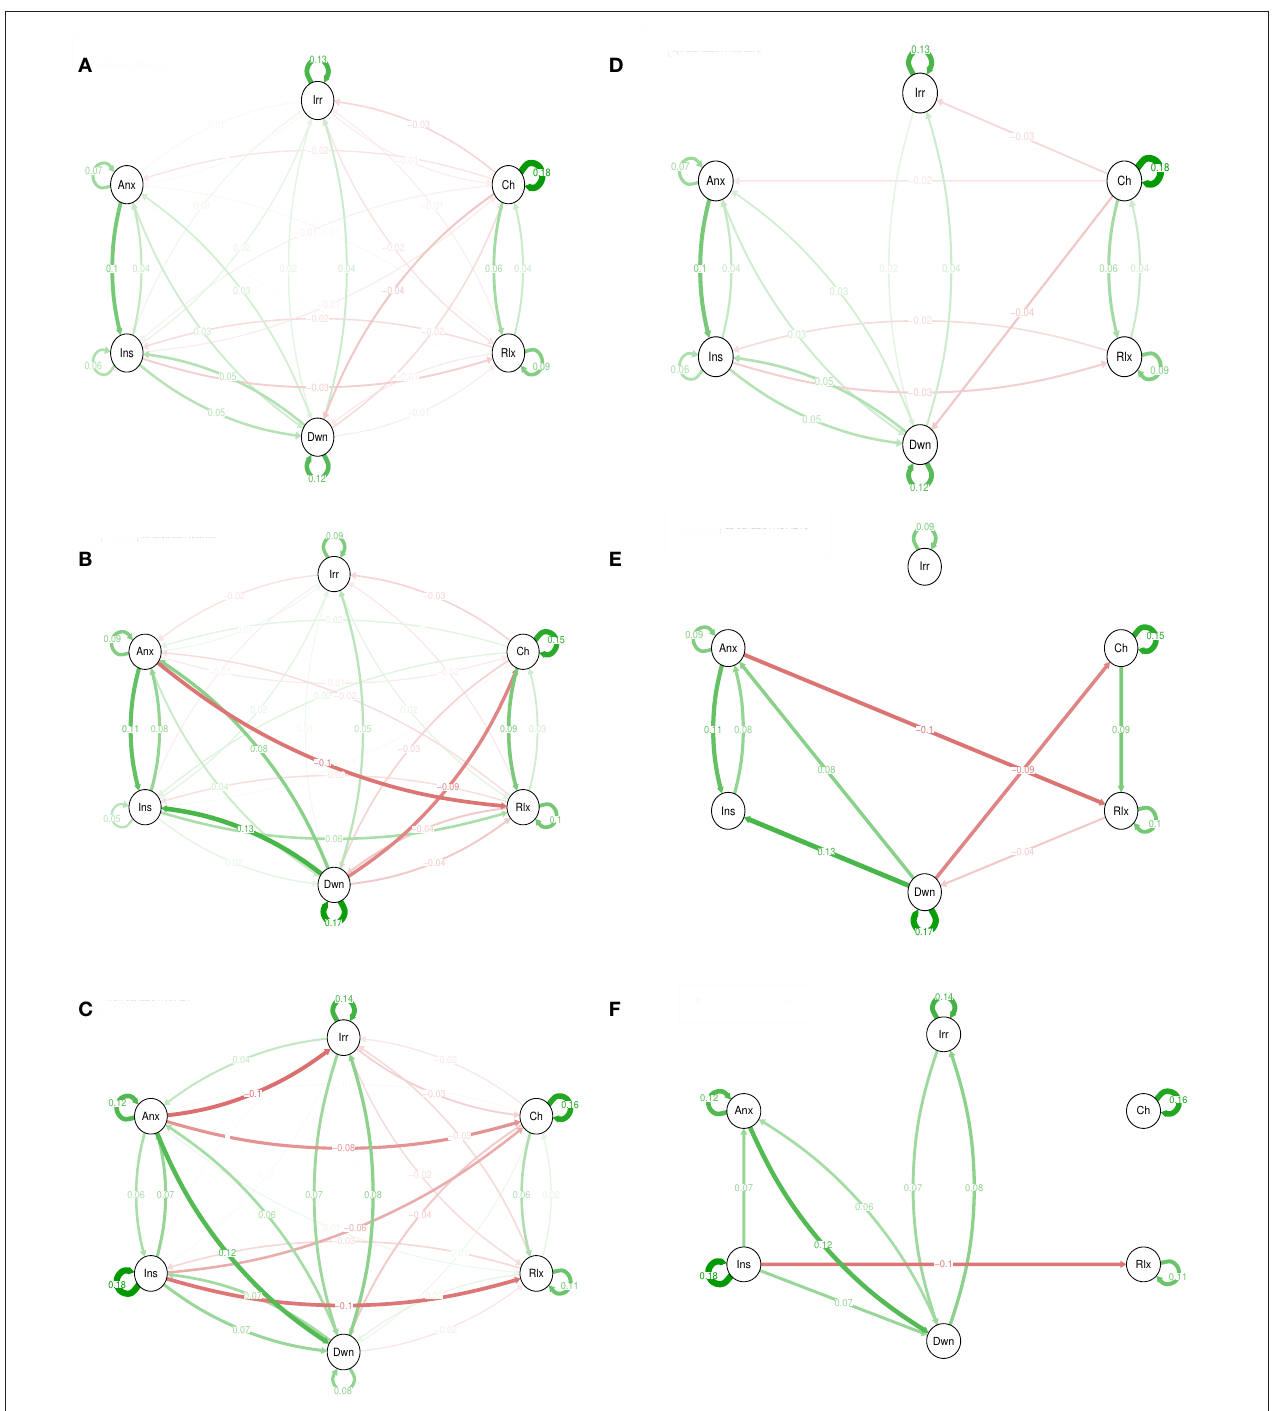
FIGURE 2 | Emotions networks in participants with low (A) , intermediate (B) , and high genetic liability for psychopathology (C) . In this figure, the arrows represent associations over time; i.e., the B coefficient expressing the effect size of the predictive associations. For example, in the low genetic liability network, there is an arrow from “relaxed” to “cheerful,” meaning that “relaxed” at t − 1 predicts “cheerful” at t with a B coefficient of 0.04. Green arrows represent positive associations, and red arrows represent negative associations. The fading of the lines represents the strength of the association and are determined by the regression weights: the more solid the line, the stronger the association (and vice versa). Note that we can predict the emotion item from the previous state of the item itself. These arrows are the self-loops in the network . Graphs (A–C) are for low, intermediate, and high GL respectively. The Graphs (D–F) are for low, intermediate, and high GL respectively but only with associations that resisted to Simes correction for multiple testing with p <